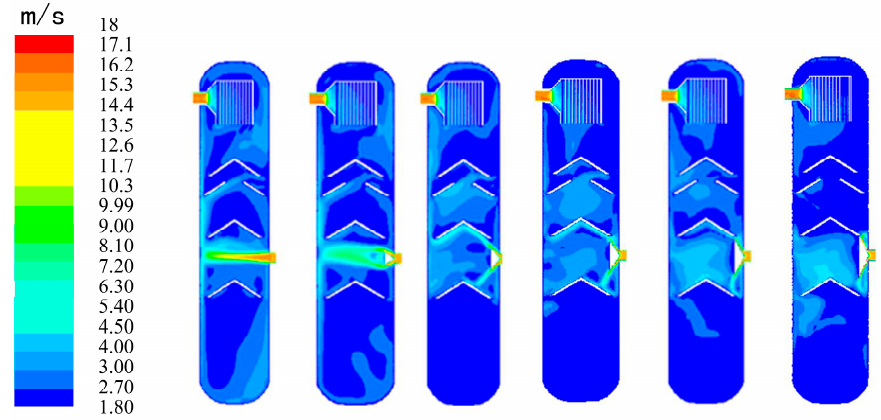
Figure 8. Collation map of separator’s velocity distribution after improving diversion device’s angle.